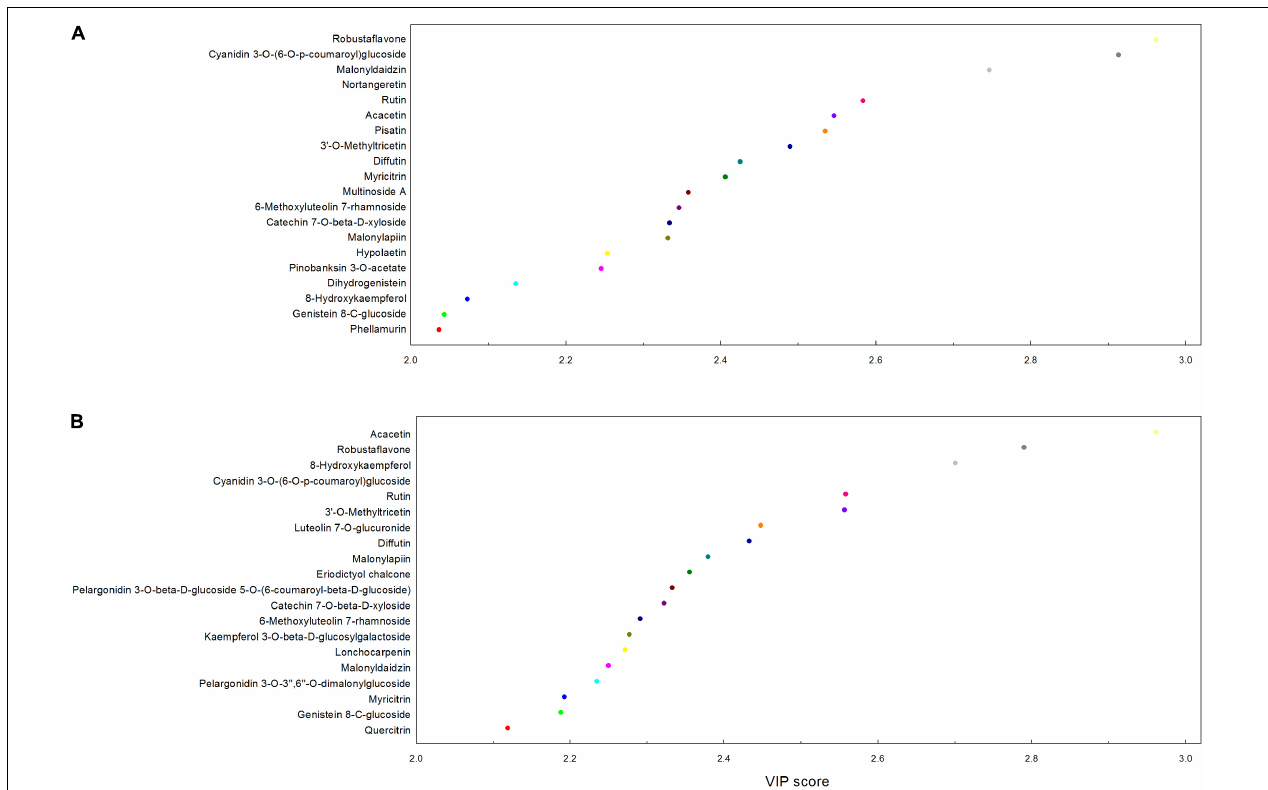
FIGURE 2 | Variable importance in projection (VIP) score of the top 20 flavonoids in each compared group. Results were from the PLS-DA. (A) S2 versus S3 and (B) S1 versus S3. The VIP scores displayed the relative contribution of these flavonoids to the separation among different stems. The higher the VIP score, the larger the contributions. Stem_young, stem_older, and stem_oldest were renamed as S1, S2, and S3,